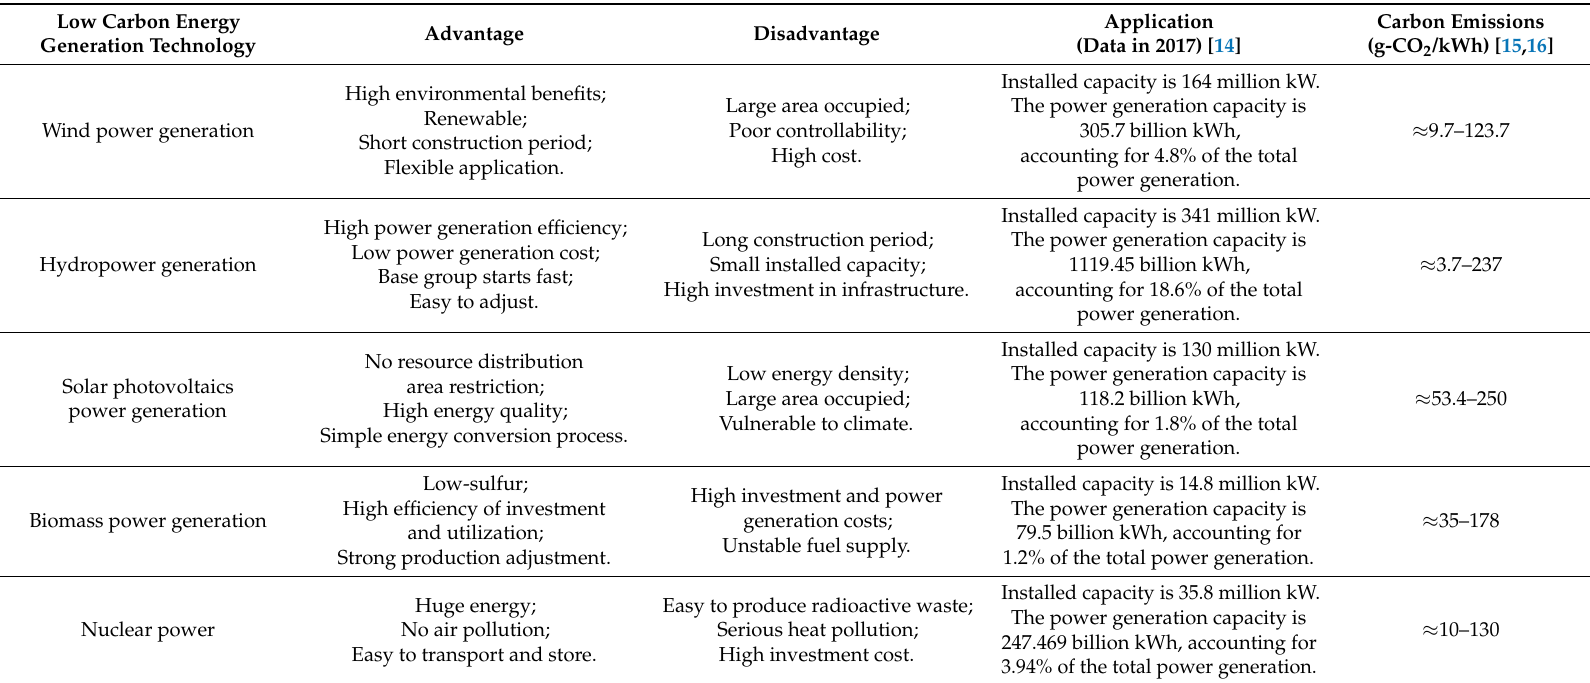
Table 1. A summary of China’s major low carbon energy generation